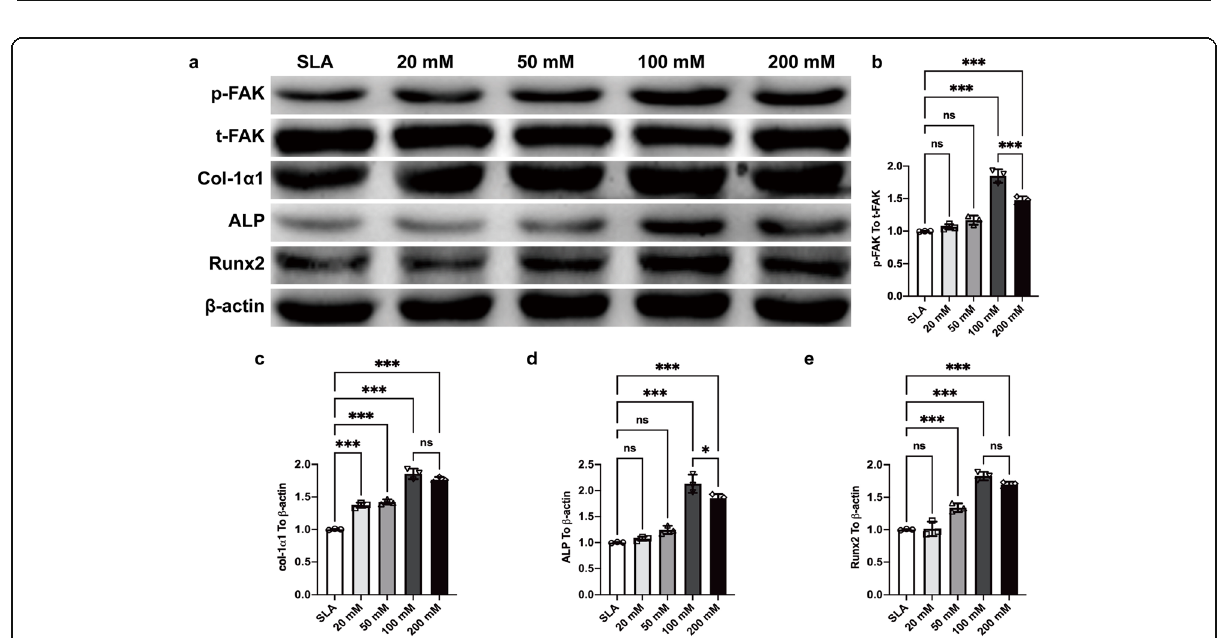
Fig. 11 Immunoblot analysis of the expression of phosphorylated and total FAK at day 3 and col-1 α 1, ALP, Runx2 and β -actin at day 7 after BMSC seeding and osteogenic differentiation on SLA discs treated with different concentrations of sodium bicarbonate ( a ). Semiquantitative analysis of immunoblots of phosphorylation of total FAK ( b ), col-1 α 1 ( c ), ALP ( d ) and Runx2 ( e ) normalized to β -actin by ImageJ. Data are presented as the mean ± standard deviation ( n = 3, * P < 0.05; ** P < 0.01; *** P <